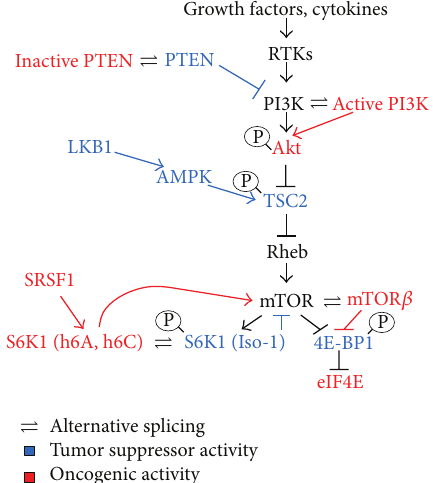
⇌ Alternative splicing Tumor suppressor activity Oncogenic Figure 2: Alternative splicing regulation of the PI3K-mTOR pathway. Growth factors and cytokines activate receptor tyrosine kinases (RTKs) which in turn lead to activation of PI3K. PI3K phosphorylates phospholipids inducing the recruitment of Akt to the plasma membrane and its activation by PDK1. A splicing variant of the catalytic subunit of PI3K (p37 delta) is an active form that enhances PI3K activity. Akt phosphorylates and inactivates the tumor suppressor TSC2, which inhibits the small GTPase Rheb. GTP-bound Rheb can activate mTOR. mTOR 𝛽 is an active splicing isoform of mTOR. mTOR phosphorylates S6K1 and 4E-PB1. 4E- BP1 phosphorylation induces its release from eIF4E, enhancing cap- dependent translation and malignant transformation. Oncogenic splicing factor SRSF1 can affect the alternative splicing of S6K1 inducing oncogenic short isoforms of this kinase (h6A, h6C) which bind mTOR and enhance 4E-BP1 phosphorylation and cap- dependent translation. Blue: tumor suppressors, red: